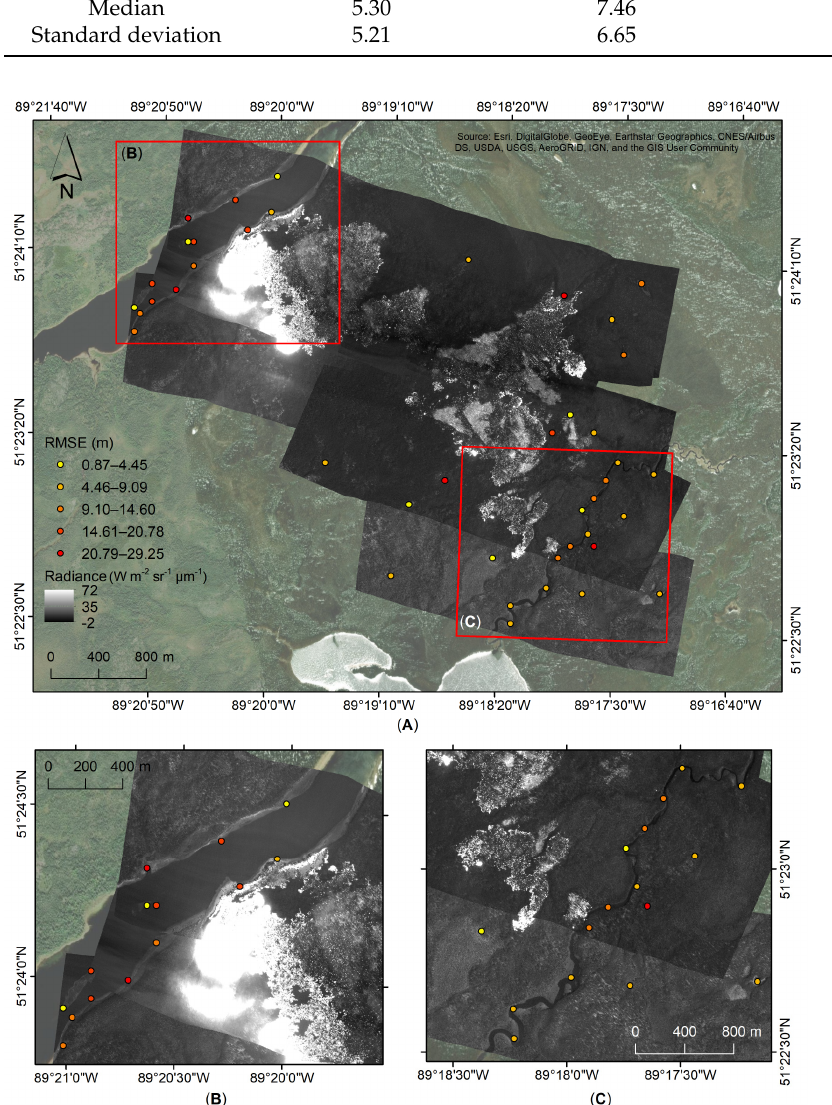
Figure 11. ( A ) Reported RMSE following the georeferencing process of the FLIR imagery in units of Radiance (Wm − 2 sr − 1 µm − 1 ) acquired on 3 August 2017, F-04, at the 1.4 ms integration time. Areas showing RMSE following the georeferencing process for ( B ) the northwest and ( C ) southeast corners of the flight lines.